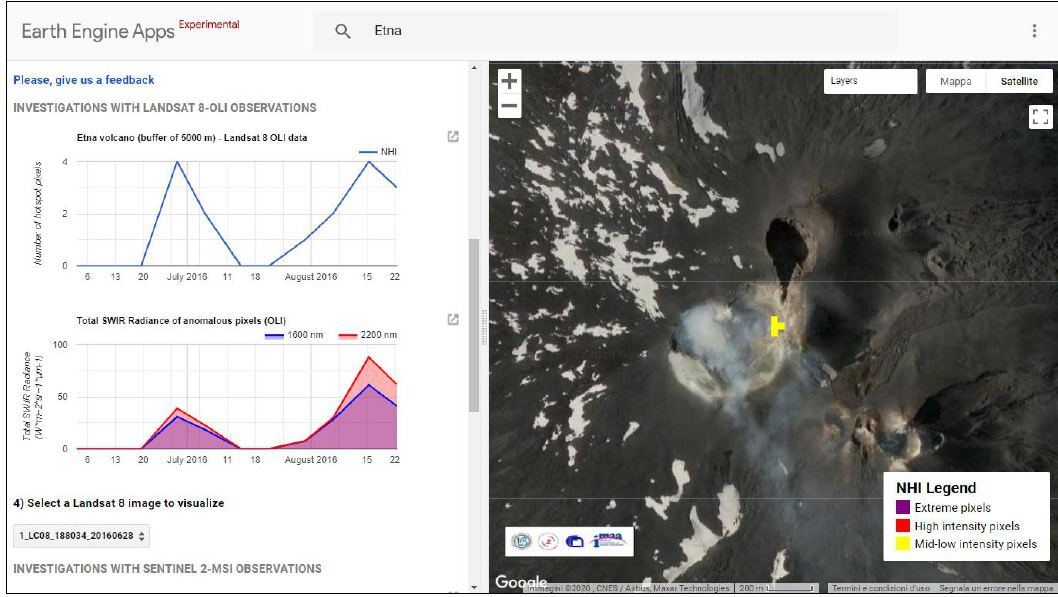
Figure 8. Mt. Etna ( 37°45′03.69″N 14°59′38.51″E ) (Sicily; Italy) thermal activity of June – August 2016 investigated through the NHI tool. On the left, temporal trend of hot spot pixels (blue curve) and chart of total SWIR radiance (blue / red curves); on the right, hot spot pixels (in yellow) detected on L8-OLI scene of 28 June 2016, a ff ecting the area where a new vent opened on 7 August 2016.